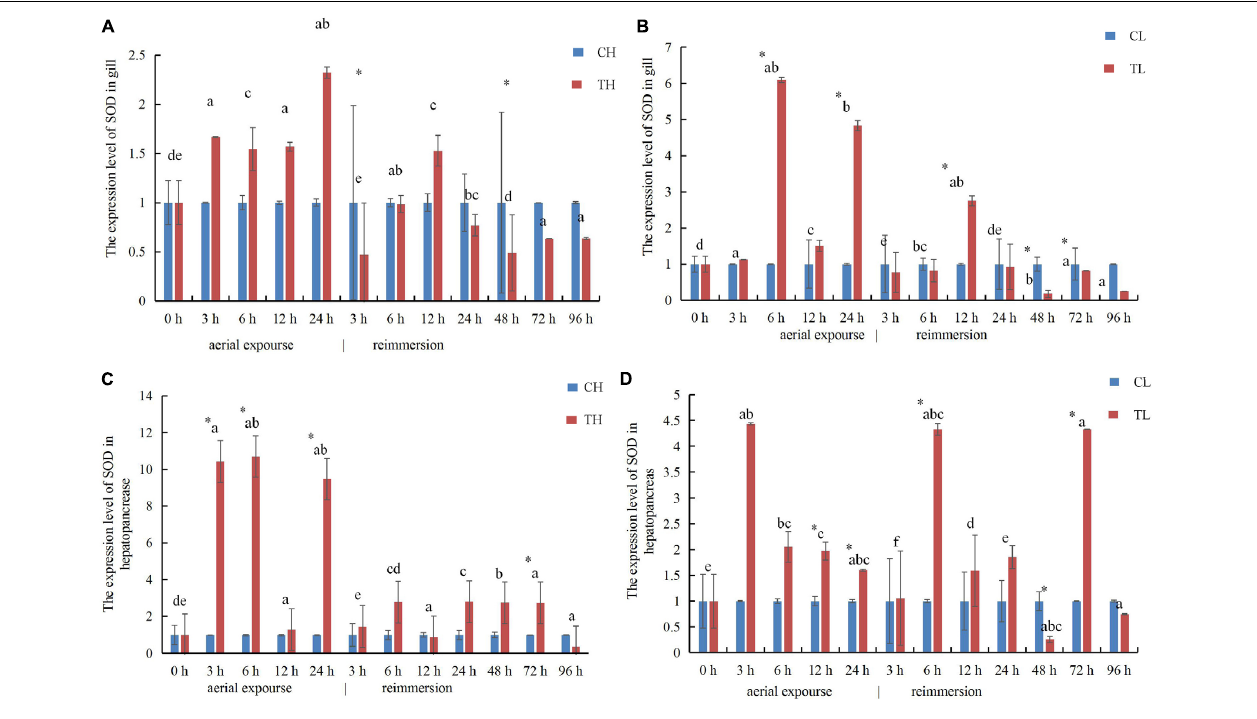
FIGURE 9 | The expression analysis of SOD in the gill of R. philippinarum under aerial exposure and reimmersion at high (A) and low temperature (B) . The expression analysis of SOD in the hepatopancreas of R. philippinarum under aerial exposure and reimmersion at high (C) and low temperature (D) .